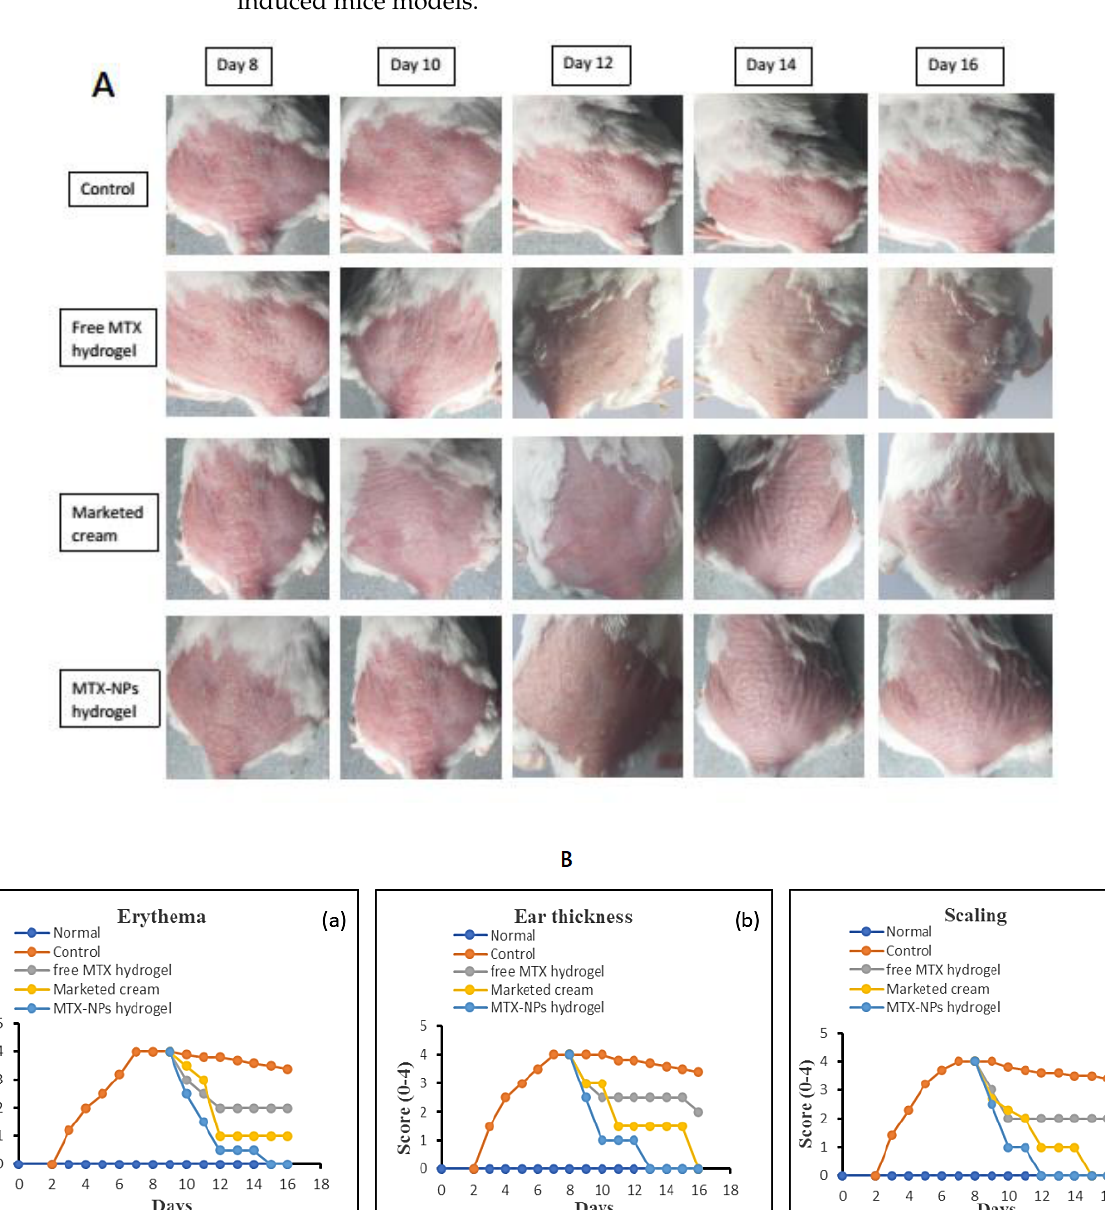
Figure 10. ( A ) Antipsoriatic activity of various formulations (free MTX hydrogel, marketed cream & MTX-NPs hydrogel) in IMQ-induced mice in comparison with control (with no treatment) (n = 5). ( B ) ( a – c ) showing assessment of psoriasis severity index score of various formulations treatment, i.e., (free MTX hydrogel, marketed cream & MTX-NPs hydrogel) in IMQ-induced mice in comparison with control (with no treatment) (n = 5).